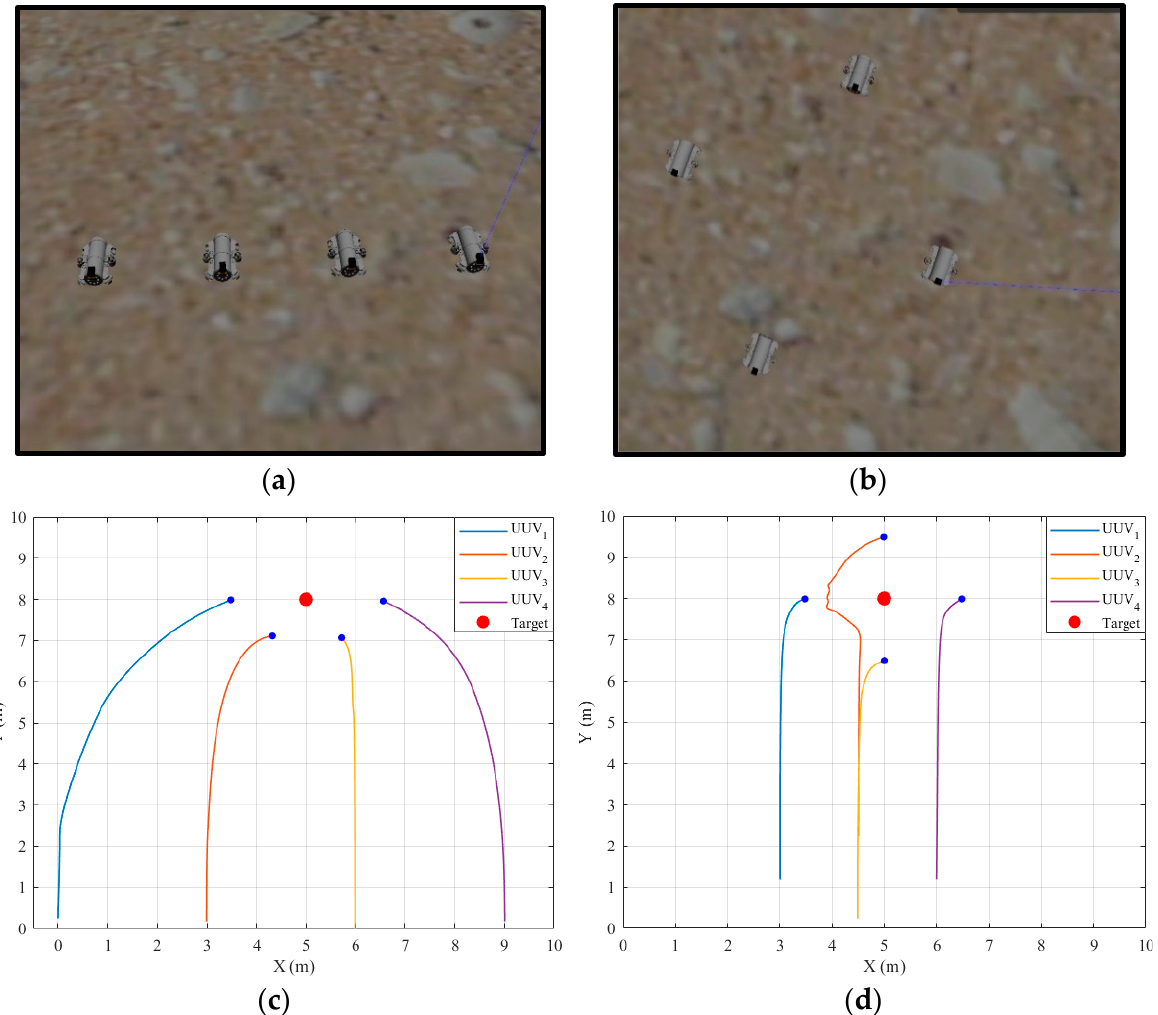
Figure 13. Simulation results of target hunting. ( a , b ) The running results of two experiments on the simulation platform. ( c , d ) The UUV trajectories of the two experiments.